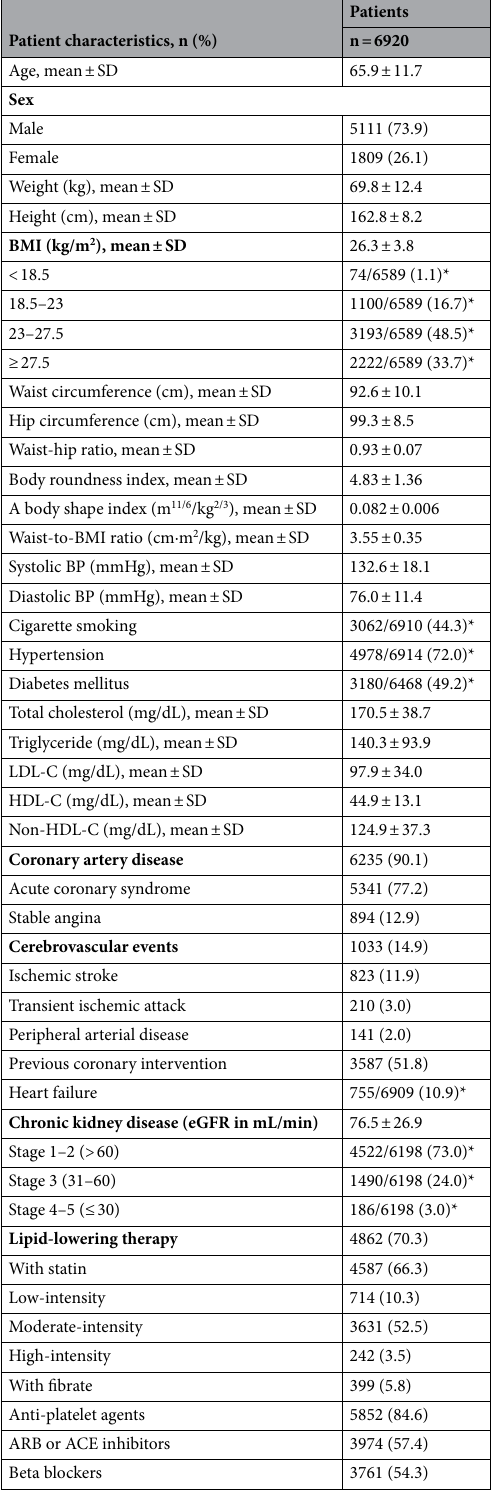
Table 1. Baseline characteristics of patient study. Data are presented as number (percentage) or mean ± SD. ACE Angiotensin-converting enzyme, ARB Angiotensin II receptor blocker, BMI Body mass index, BP Blood pressure, eGFR Estimated glomerular filtration rate, HDL-C High-density lipoprotein cholesterol, LDL-C Low-density lipoprotein cholesterol. *Means that there were missing values, and the actual numerators and denominators are